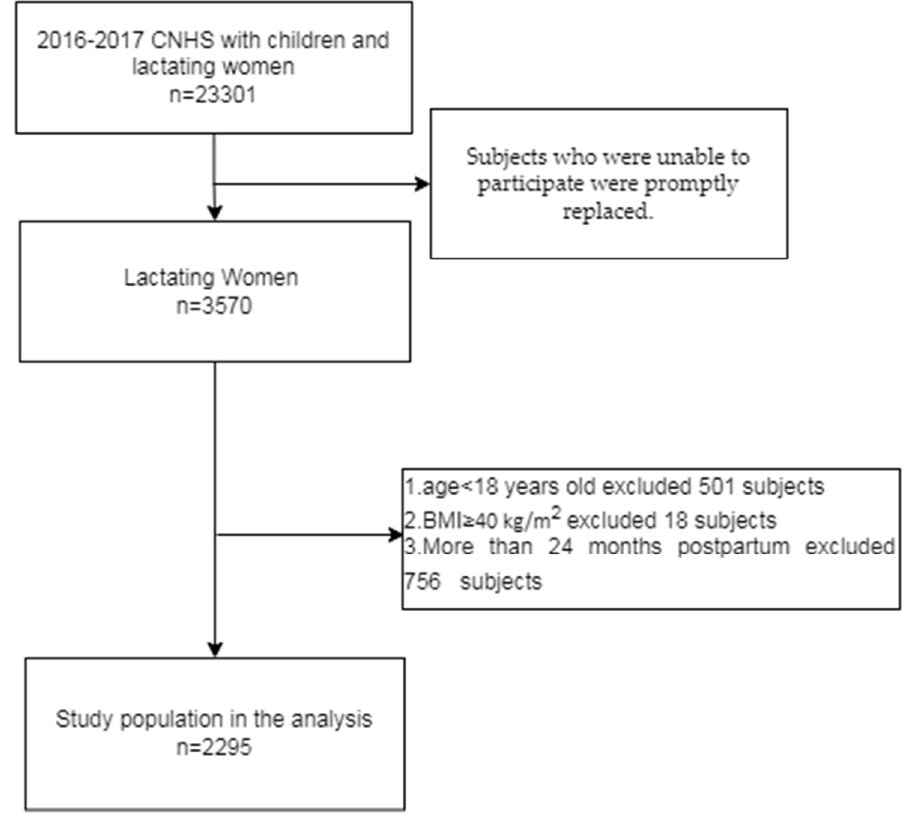
Figure 1. Inclusion and Exclusion Flowchart.